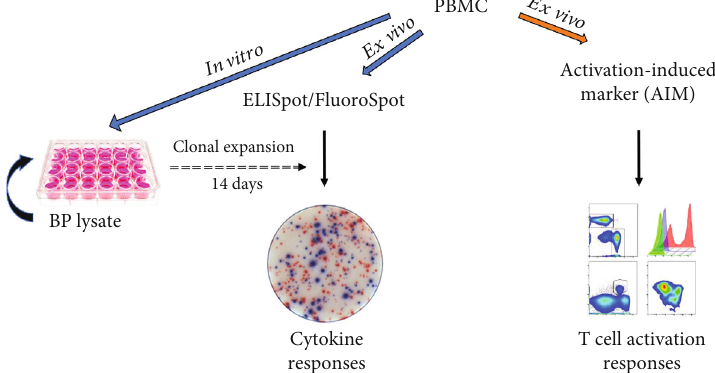
Figure 2: Approaches for genome-wide screening and measurement of T cell reactivity. Schematic design for the screening of BP whole genome using di ff erent assay modalities (AIM versus ELISpot/FluoroSpot) and strategies (in vitro versus ex vivo) to capture T cell-speci fi c responses.